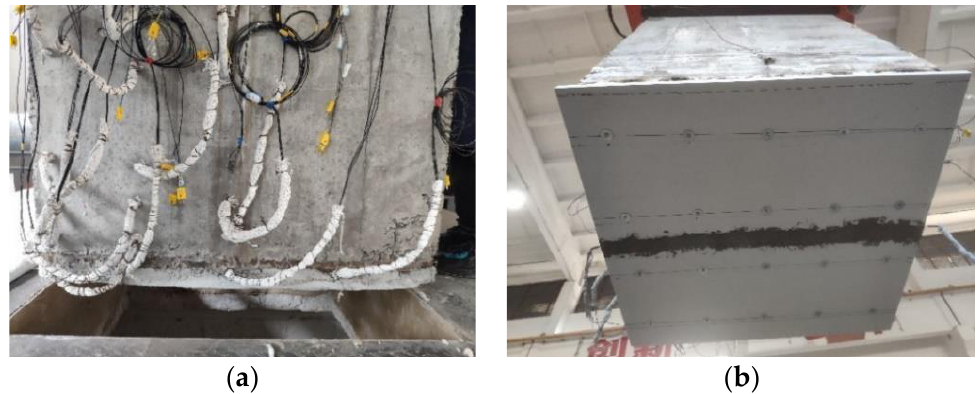
Figure 7. Complete installation of the fireproof layers. ( a ) Fireproof coating spraying finished; ( b ) fireproof board installation completed.